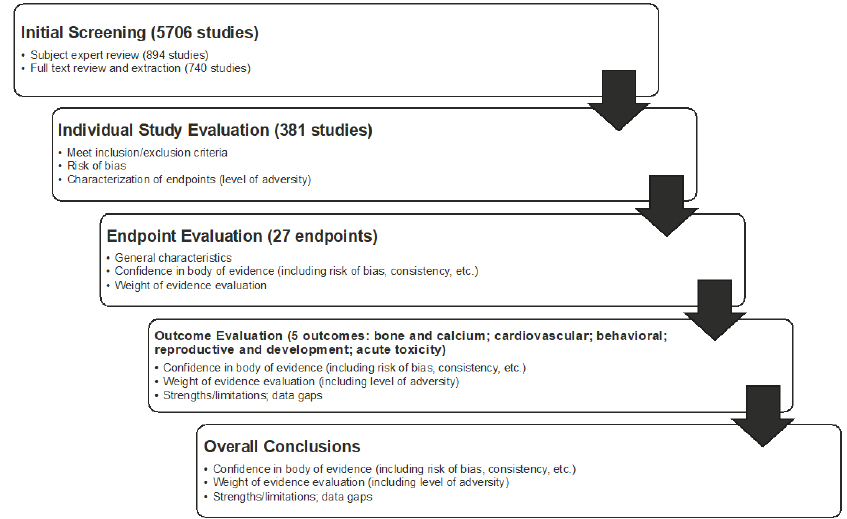
Figure 3. Review process, from initial evaluation to reaching overall conclusions.